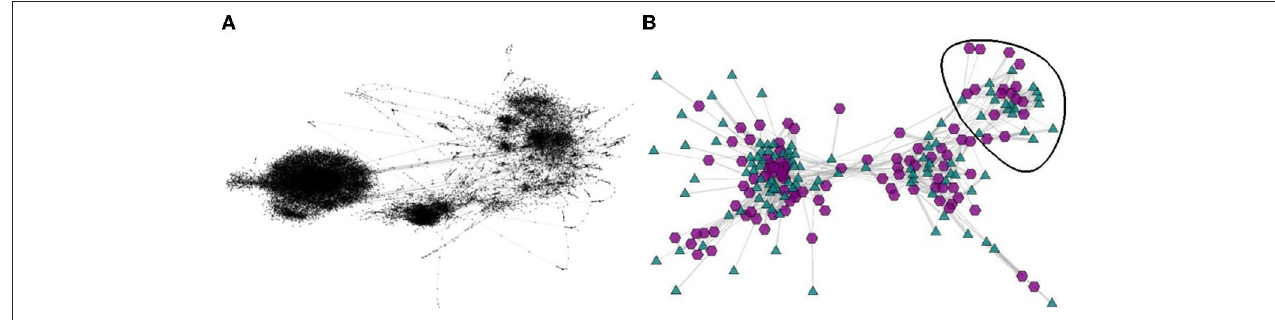
FIGURE 6 | Two renderings of the n-reactome bipartite network with 24,211 nodes (a layer with 8,788 protein nodes and a layer with 15,422 n-reactome interactions), and 41,087 links. Panel (A) depicts a rendering of the full network, replicated from https://sparse.tamu.edu/Schulthess/N_reactome; panel (B) shows a rendering obtained in BiNetViz of a coarsened representation with only 200 nodes (100 in each layer). The protein nodes are represented as purple hexagons, whereas the reactome interactions are represented as green